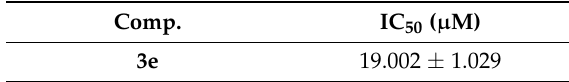
Table 3. Cytotoxic activity of the compound 3e against NIH/3T3 cell line. Comp.